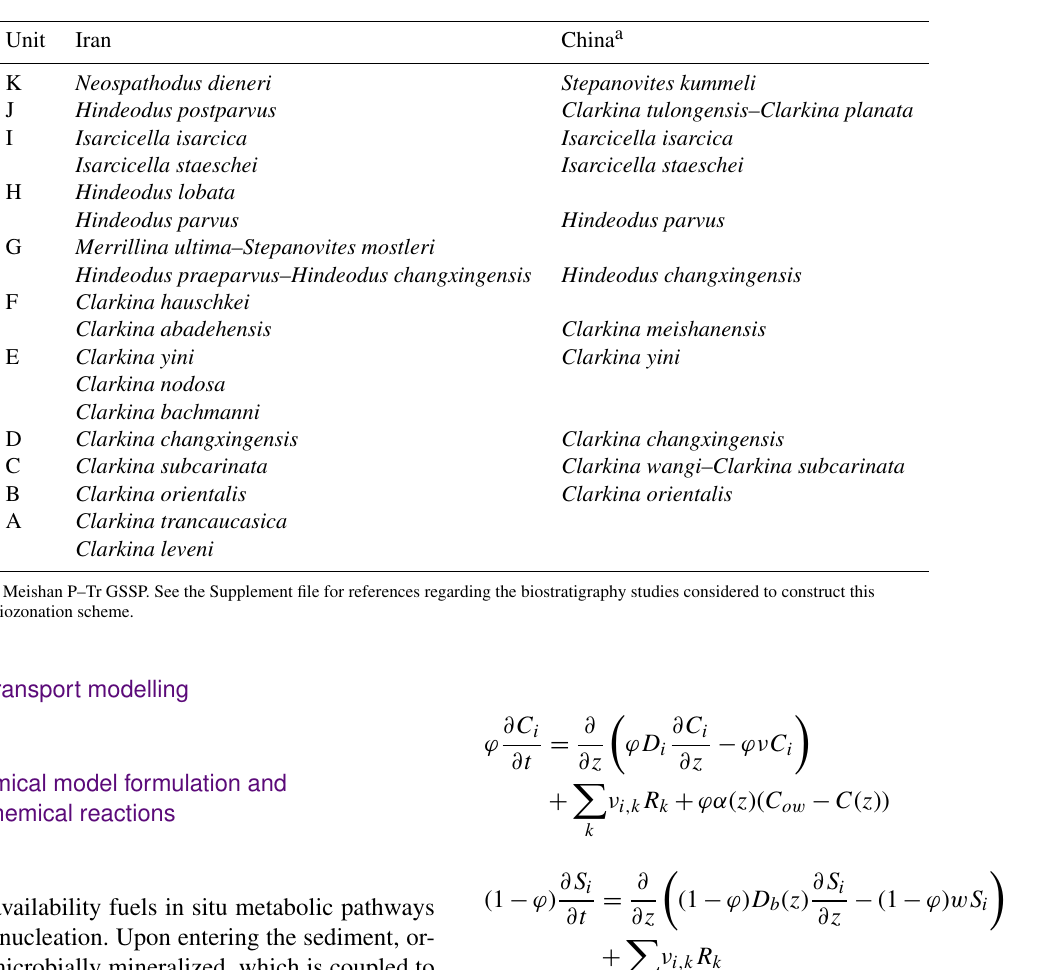
Table 1. Correlative biostratigraphic